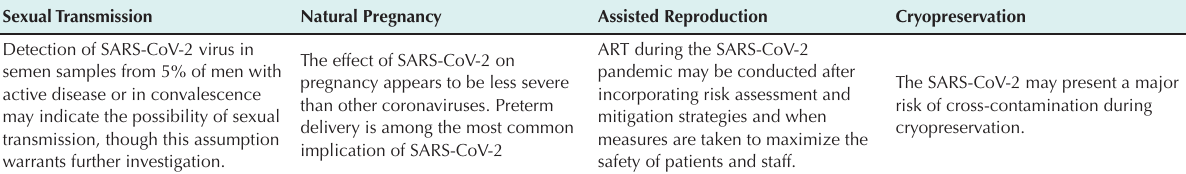
Table 1. Hypothesis and Evidence for the Possible Sexual Transmission of SARS-CoV-2 and Its Effect on Natural Pregnancy, Assisted Reproduction and Cryopreservation Sexual Transmission Natural Pregnancy Assisted Reproduction Detection of SARS-CoV-2 virus in semen samples from 5% of men with active disease or in convalescence may indicate the possibility of sexual transmission, though this assumption warrants further